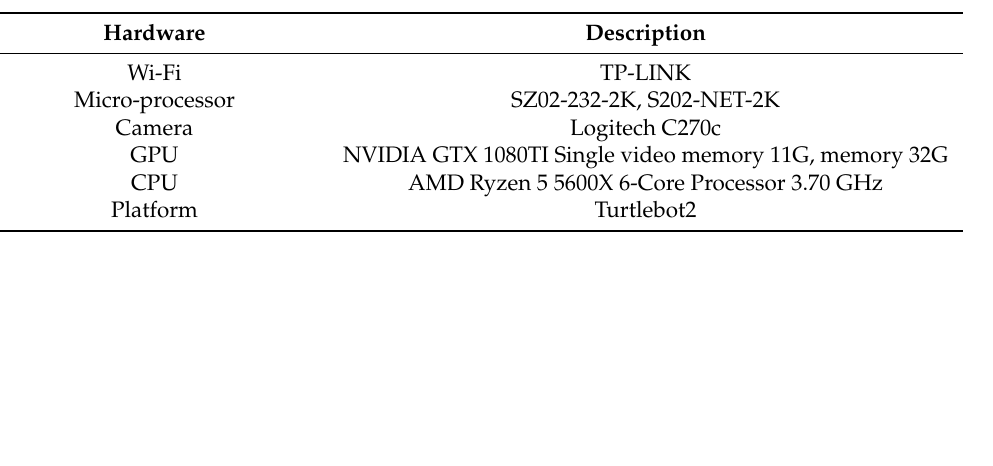
Table 2. Experimental hardware